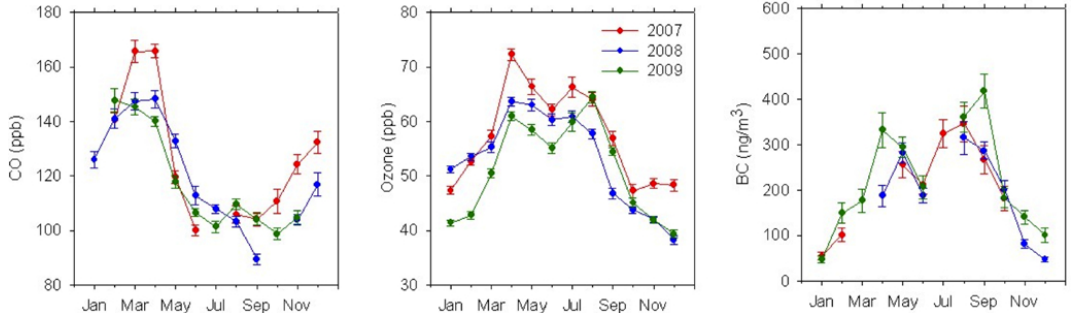
Fig. 1. Monthly means of CO, O 3 and BC at ICO-OV for the years 2007, 2008 and 2009. The error bars denote the average expanded uncertainties with p <